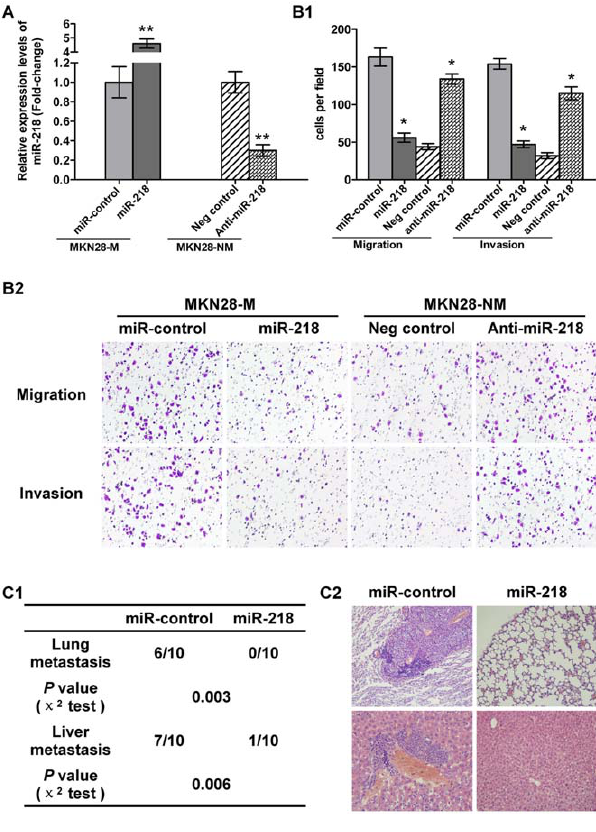
Figure 4. miR-218 suppressed tumor cell invasion and metas- tasis. (A) qRT–PCR analysis of miR-218 in MKN28-M cells transfected with the miR-218-expression vector or the miR-control vector and MKN28-NM cells transfected with anti-miR-218 or a negative control. (B) Cell invasion assay. (B1) Average number of invasive cells from three independent experiments 6 SE. * P , 0.05. (B2) Representative fields of invasive cells on the membrane. (C) In vivo metastasis assay. MKN28-M cells were transfected with the miR-218-expression vector or the miR- control vector and injected into nude mice via the tail vein, as described in Materials and Methods. Animals were killed 10 weeks after injection. (C1) Incidence of metastasis in mice. (C2) Representative H&E staining of lungs and livers isolated from mice that received injections of MKN28-M- miR-control or MKN28-M-miR-218 cells.